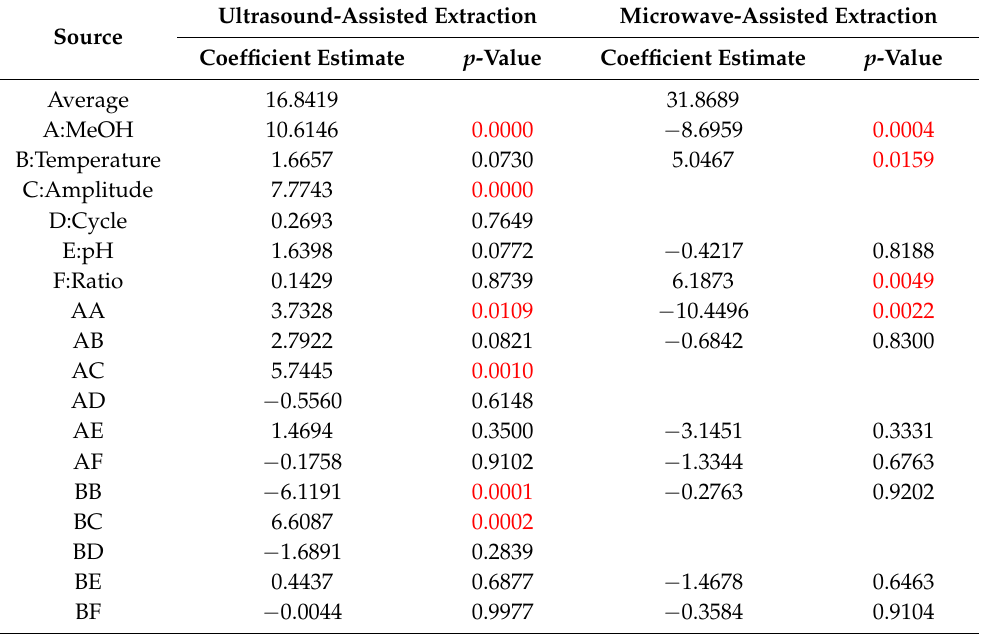
Table 3. Comparative variance analysis of the Box-Behnken variables in the ultrasound and microwave-assisted